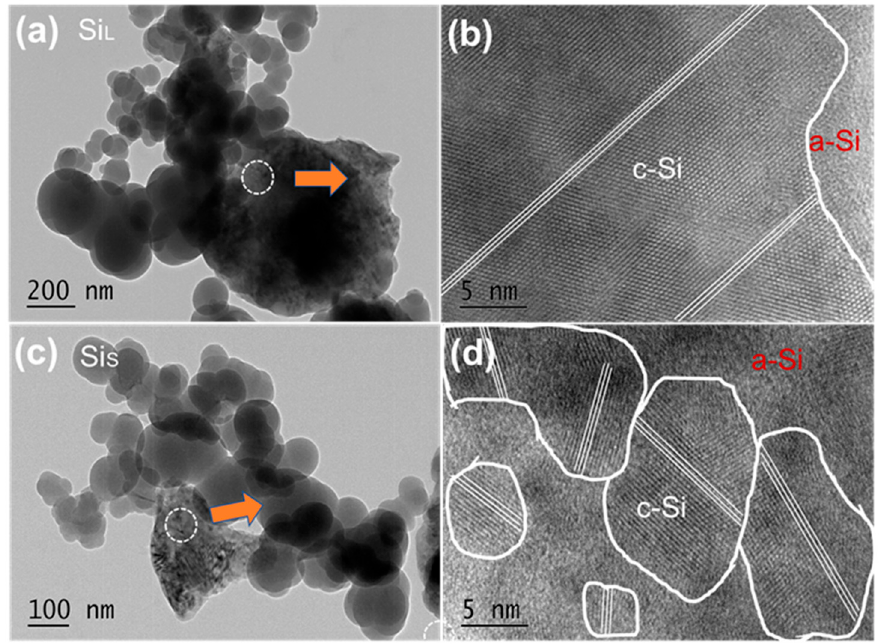
Figure 9. HRTEM images ( a , b ) of Si L and ( c , d ) of Si S